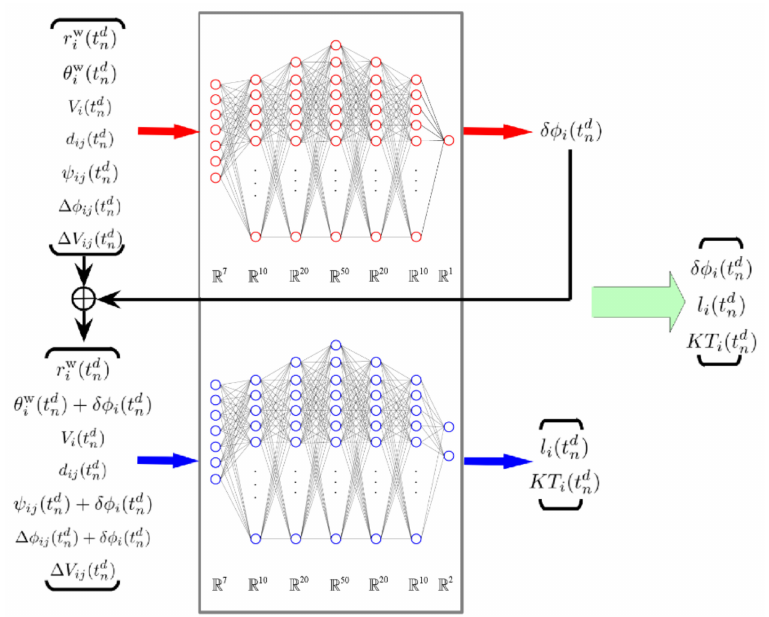
Figure 3. The structure of the pairwise interaction network. An Angle Changing Network (ACN) is laid on the top, where it receives the original environmental and the neighbor’s information. The outputs are the heading angle changing value δφ i of the focal fish at decision time t d n . The Length and Duration Network (LDN) for a straight-moving decision is laid at the bottom. The input of the LDN is the same as the ACN, but the angle value inputs ( θ W ∆ φ + δφ + δφ + δφ ( θ W i , ψ ij i , ij i ) because of the heading angle change of the focal fish. The structures i of the LDN input layer and hidden layer are similar to those of the ACN. However, the output layer of the LDN includes two neurons, which are the kick length l i ( t d n ) and the duration time of the kick KT i ( t d n )